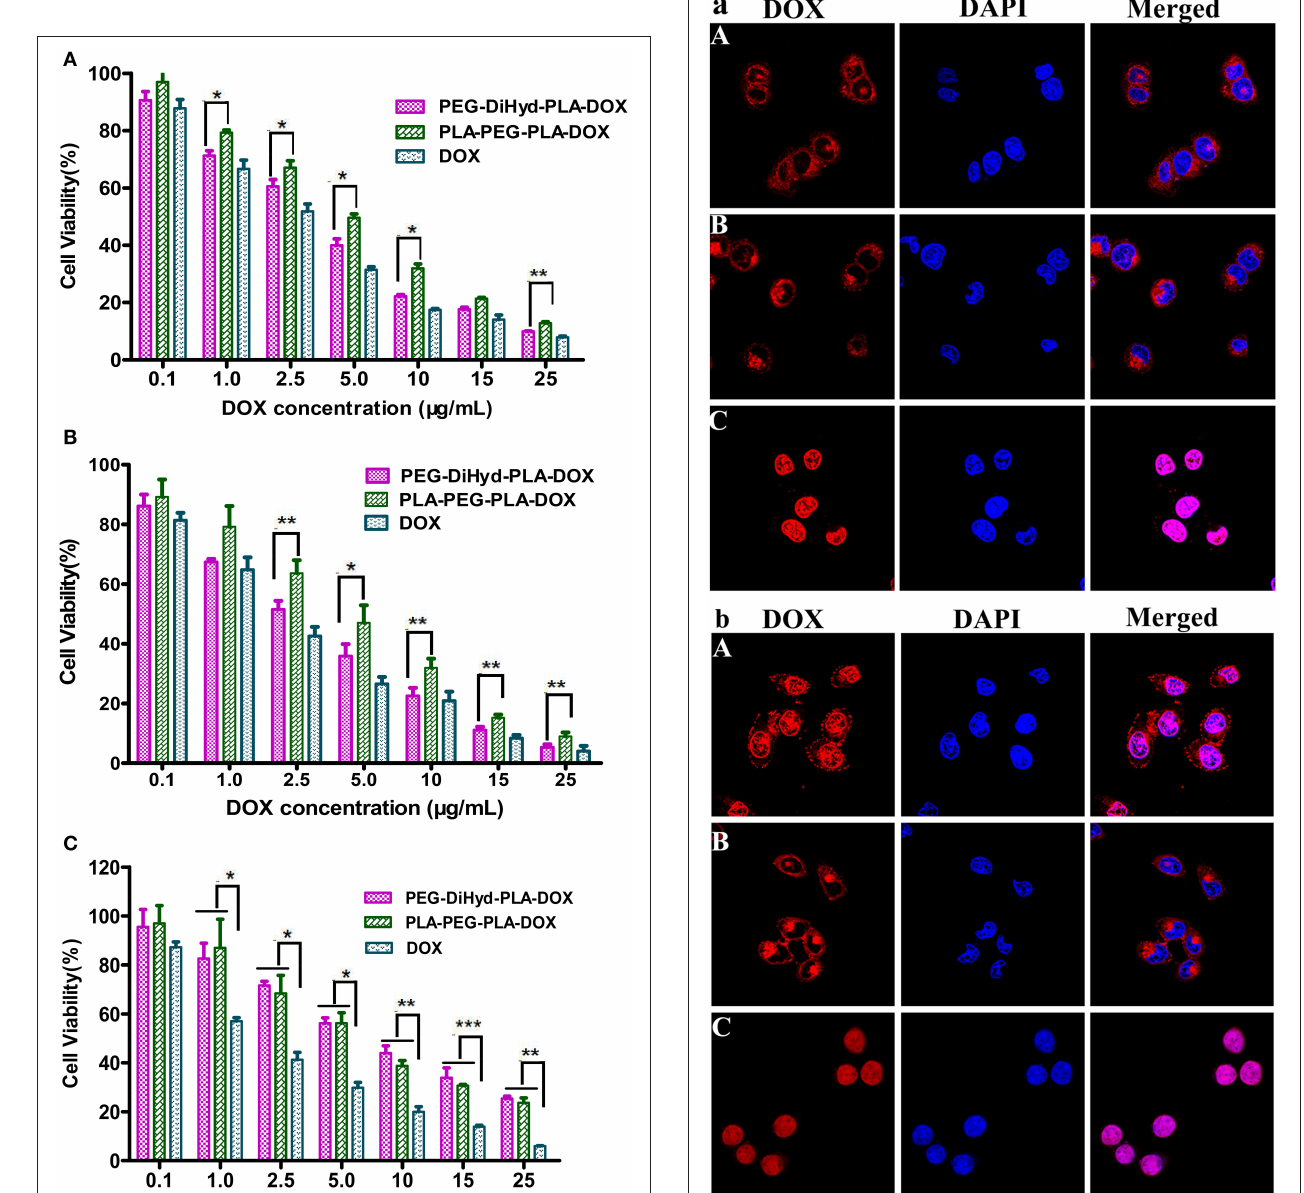
FIGURE 9 | Representative CLSM images of HepG-2 cells incubated with DOX-loaded mPEG-DiHyd-PLA-18K Micelle solution (A) , DOX loaded PLA-PEG-PLA-18K micelle solution (B) , and free DOX (C) solution for 3h (a) and 12h (b) . The cellular nuclei and cytoskeleton of cells were stained with DAPI (blue) and DOX (red), respectively. DOX concentration is 10 µ g/mL for any DOX containing